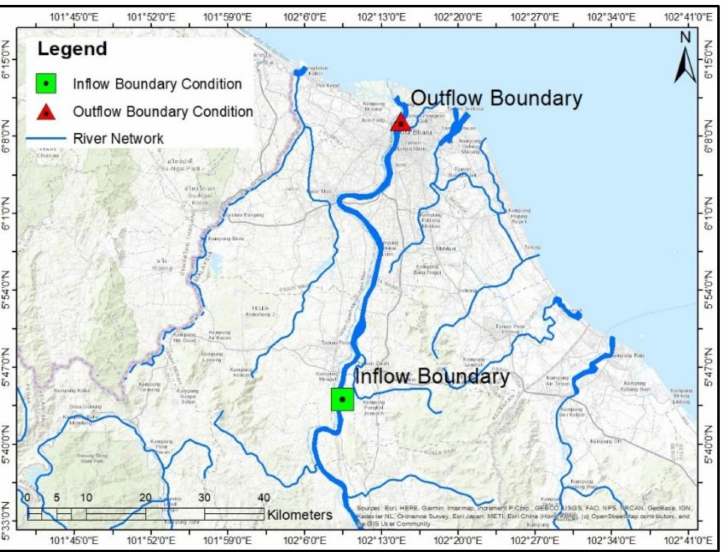
Figure 4. Location of inflow (upstream) and outflow (downstream) boundary conditions.